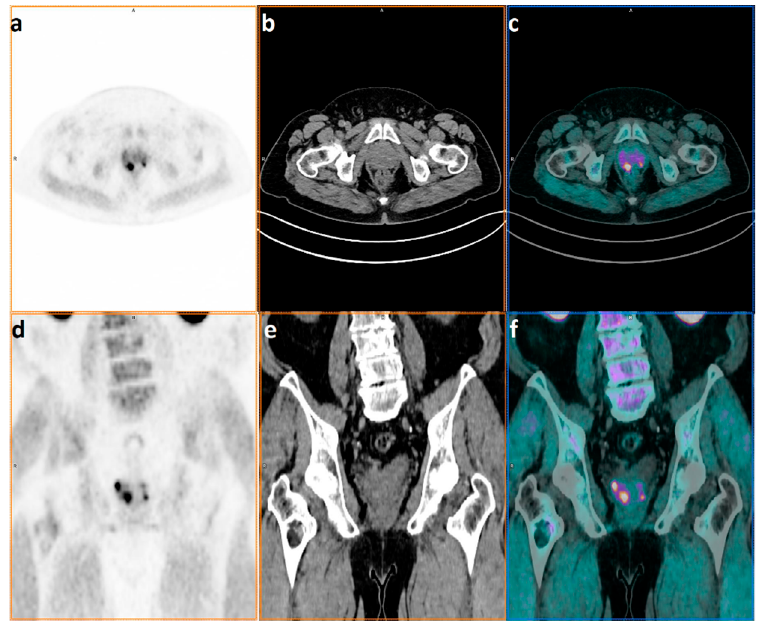
Figure 1. Patient with diagnosis of prostate cancer referred to 18 F-FECh PET/CT for staging in May 2021; Gleason Score 9 = 4+5 and PSA value at diagnosis of 9.74 ng/mL. PET only, co-registered CT only, and hybrid PET/CT images in axial ( a – c ) and coronal plans ( d – f ) showing a multifocal pattern with four areas of focal uptake in the prostate, of which the most evident is placed in the peripheral zone of the right lobe.